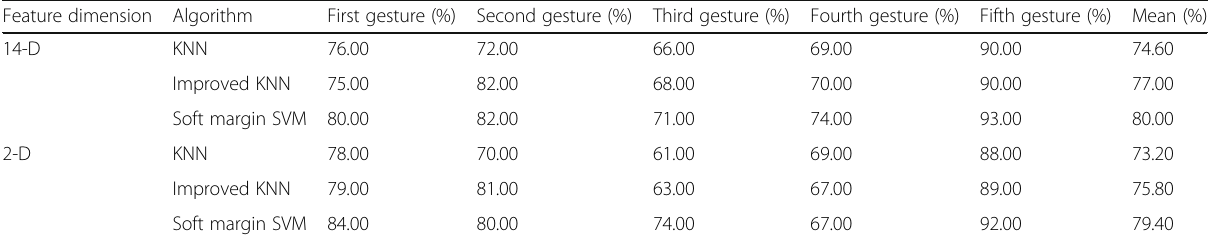
Table 2 The accuracy comparison of KNN and improved KNN and soft margin SVM for 14-D and 2-D gesture recognition Feature dimension Algorithm